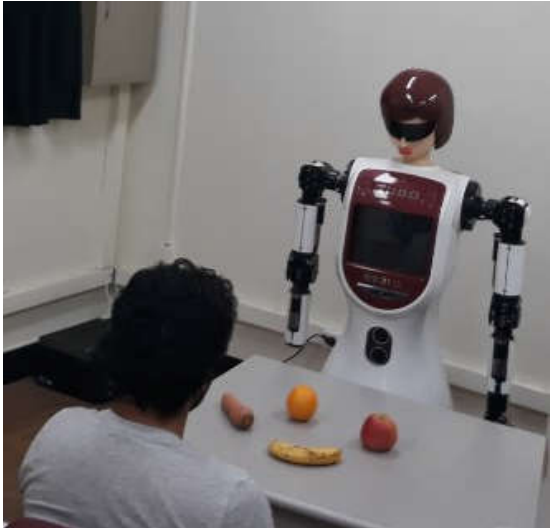
Figure 5. Emotion appraisal system implemented in a robot (TUBO) and an agent. The emotion appraisal system was implemented with an IBM PC in the Visual C++ environment and implemented by programming the modules depicted in Figure 4. Link Grammar Parser’s Penn Treebank was used as the syntactic parser [33], and